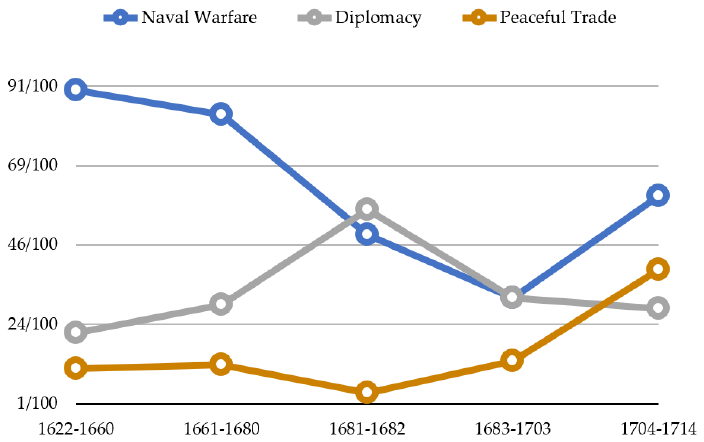
Figure 3. References to maritime combat, diplomacy and trade by period (British and European relations).